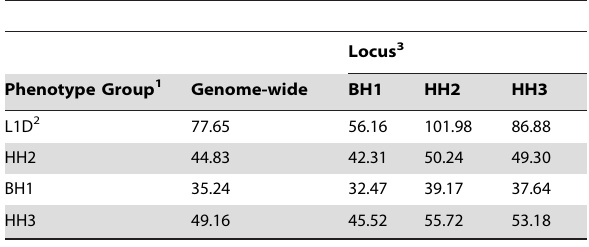
Table 2. Count of heterozygous SV discovered in concordance with haplotype carrier